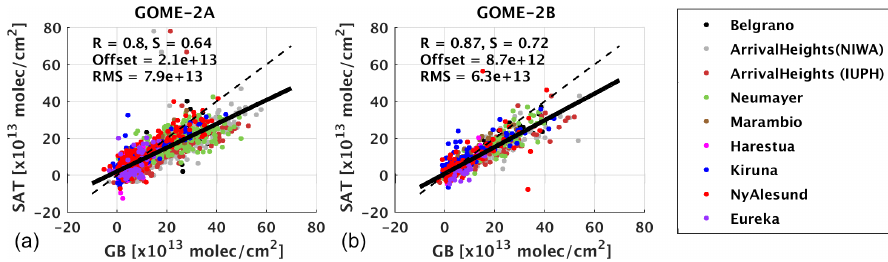
Figure 18. Scatter plot between daily GOME-2A (a) and GOME-2B (b) GDP 4.8 satellite data and ground-based data at the different stations included in the study for the activated months (July, August, and September (JAS) for stations in the SH and January, February, and March (JFM) for stations in the NH). The stations are color coded, and the total regression statistics are given in each panel.